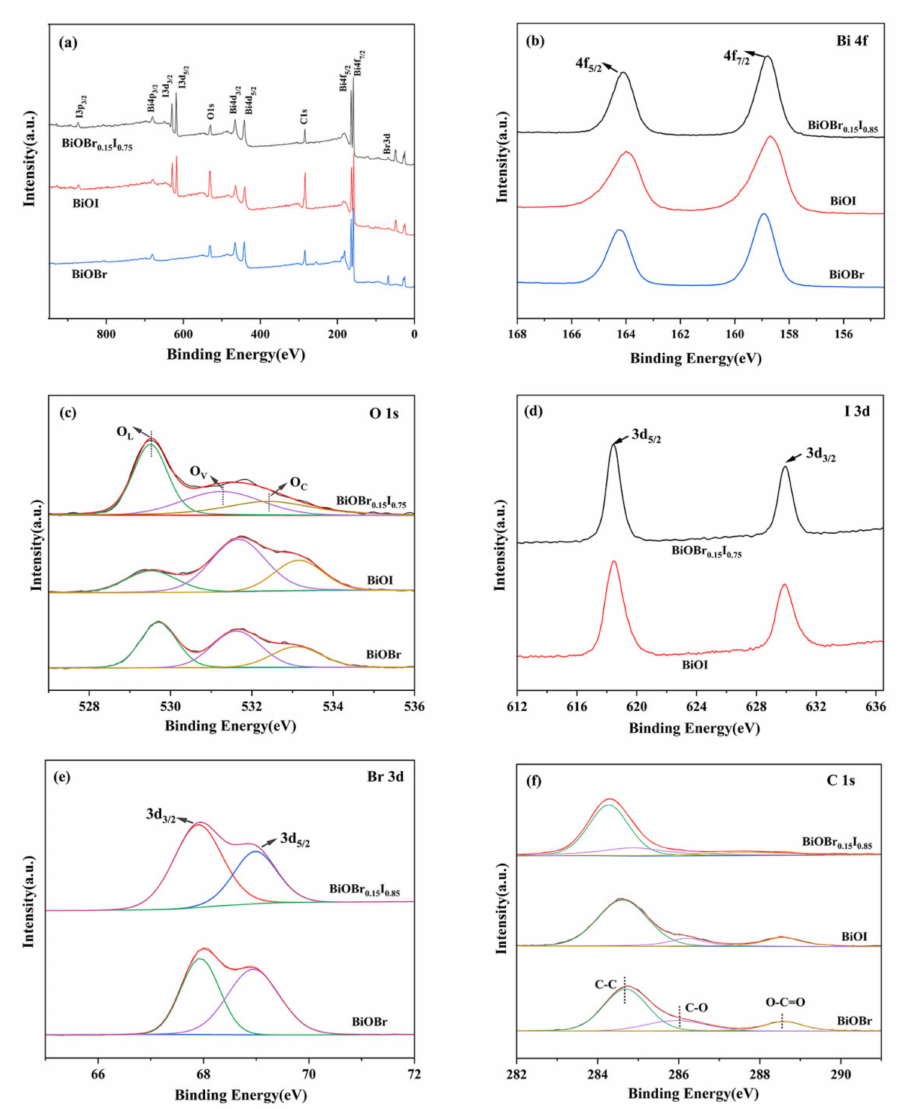
Figure 4. XPS spectra of samples: ( a ) survey; ( b ) Bi 4f spectrum; ( c ) O 1s spectrum; ( d ) I 3d spectrum; ( e ) Br 3d spectrum; and ( f ) C 1s